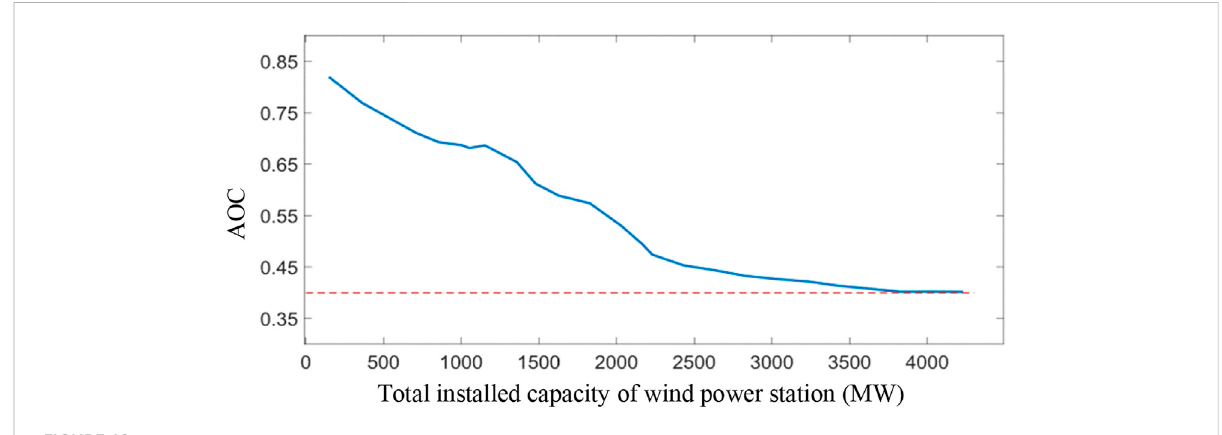
FIGURE 12 AOC of regional wind power stations with different total regional installed